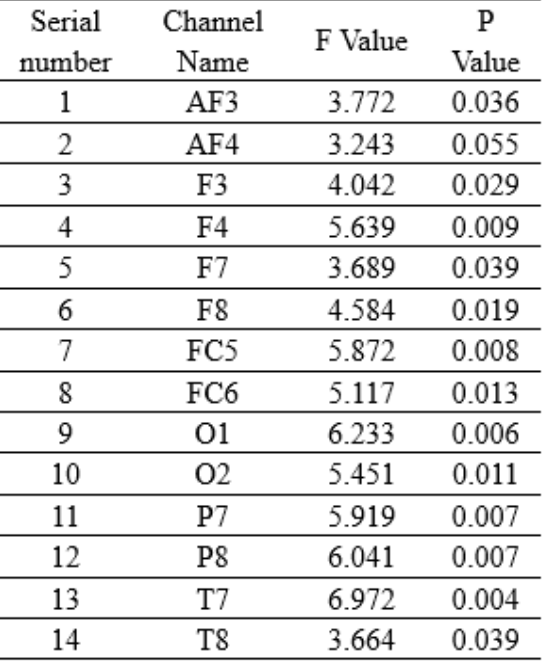
Table1. Significant result on 14 channels for RMS value after applying one way ANOVA. Differ - ence between NWL and LWL after applying post